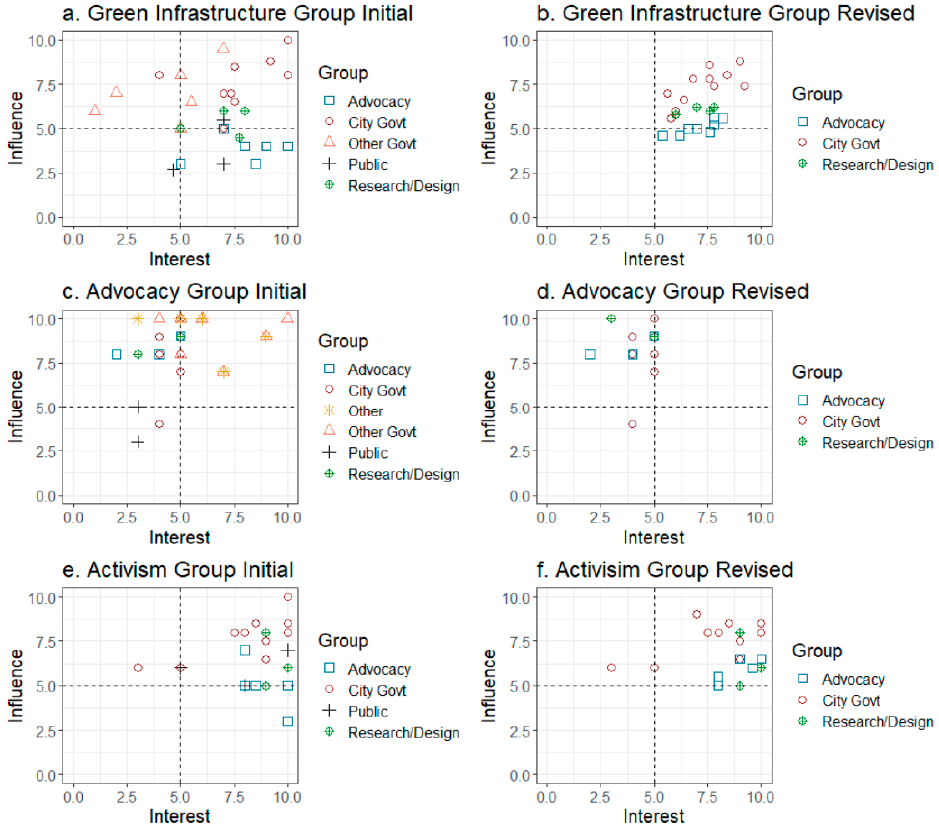
Figure 3. Results of a stakeholder analysis for NYC stormwater management regarding the initial placements of stakeholder categories and the final placement of stakeholder groupings from: ( a , b ) a green research infrastructure group, ( c , d ) an advocacy group, and ( e , f ) an activism group.